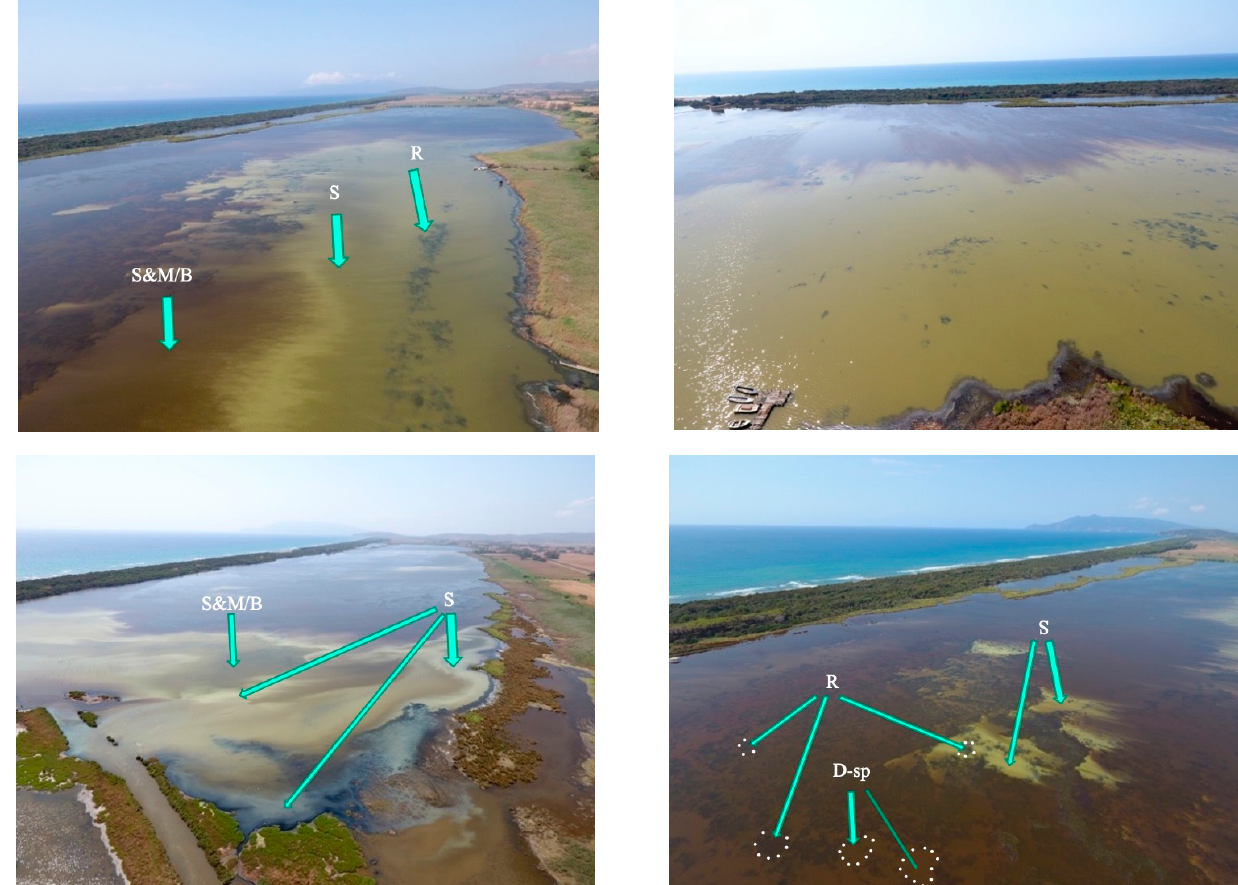
Figure 6. The Burano lagoon. Photos taken with drone on 16–18 August 2021. Top left image, extensive dystrophic phenomenon along the continental shoreline of the basin. The dark mottled strip, near the coast, consists of seagrass patches (R arrow); the yellow colour is produced by colloidal sulfur originating from oxidation of hydrogen sulfide released during the bacterial sulfate-reduction process (S arrow); the brown colour, more central, is the mixing of microphytic blooms, bacterioplankton and nanoparticulate with colloidal sulfur (S&M/B arrow). Top right image, detail of the